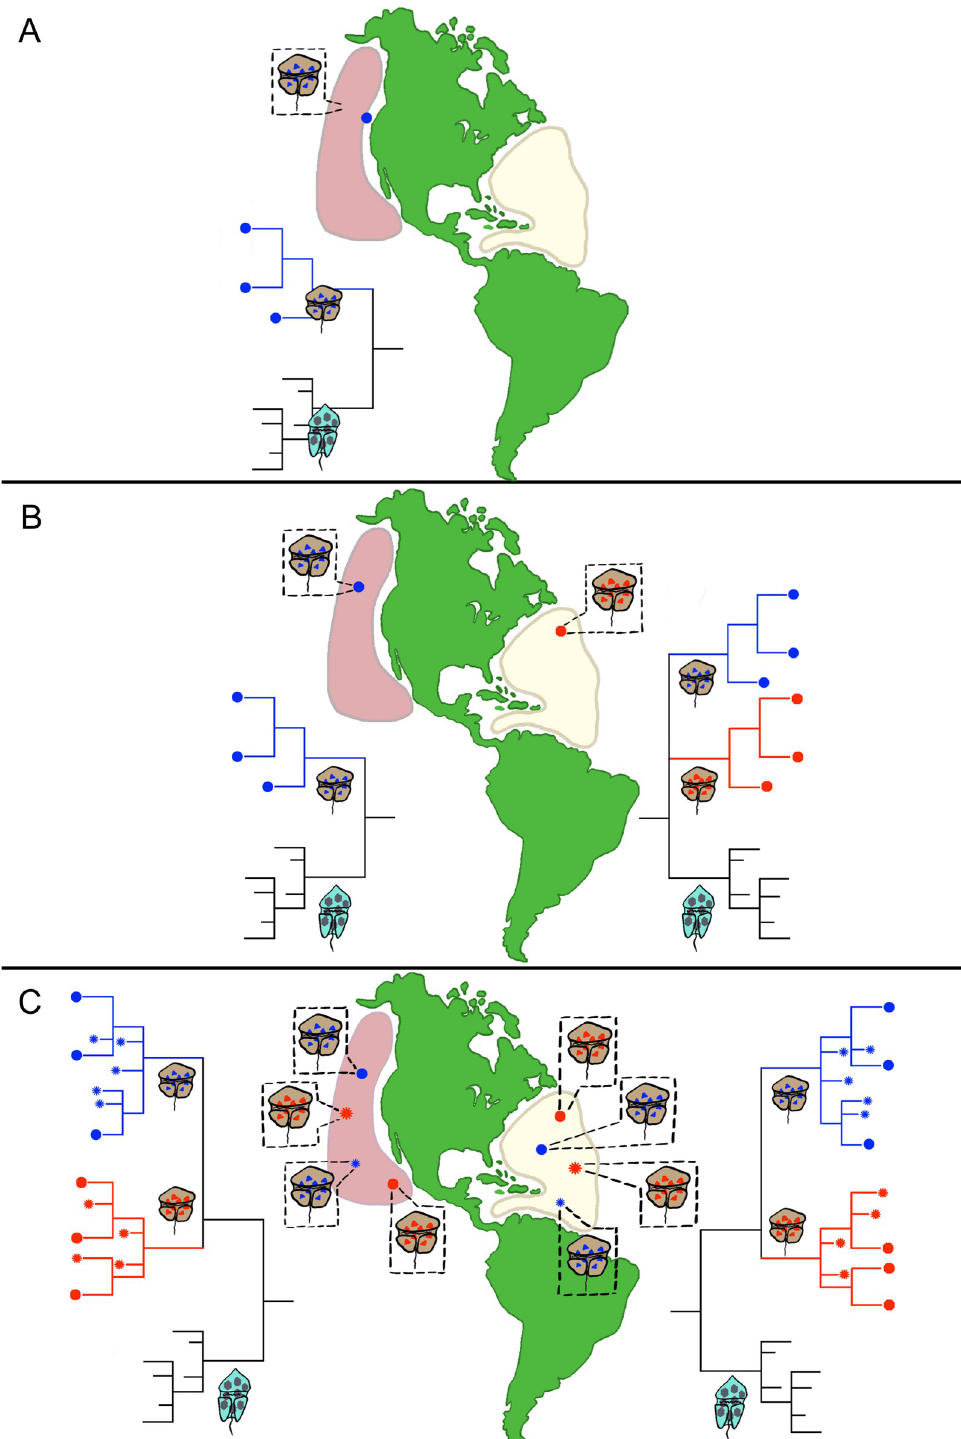
Fig 5. Diagram illustrating how various morphological and molecular phylogenetic information can be used in describing dinoflagellate species. Panel A) Example of a case where morphologically distinct isolates from the Pacific region (represented by the brown cell) compared to the morphology of a related, previously described, co-occurring species (represented by the bluish-green cell). The morphological differences were found to be distinct and non- overlapping with previously described species, supporting describing the new isolates as a separate species.